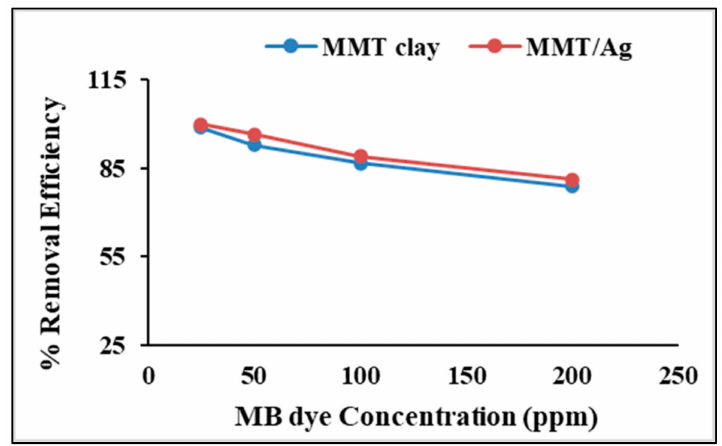
Figure 9. EffectofinitialMBconcentrationonadsorptionbyrawMMTclayandMMT/Agnanocomposite.